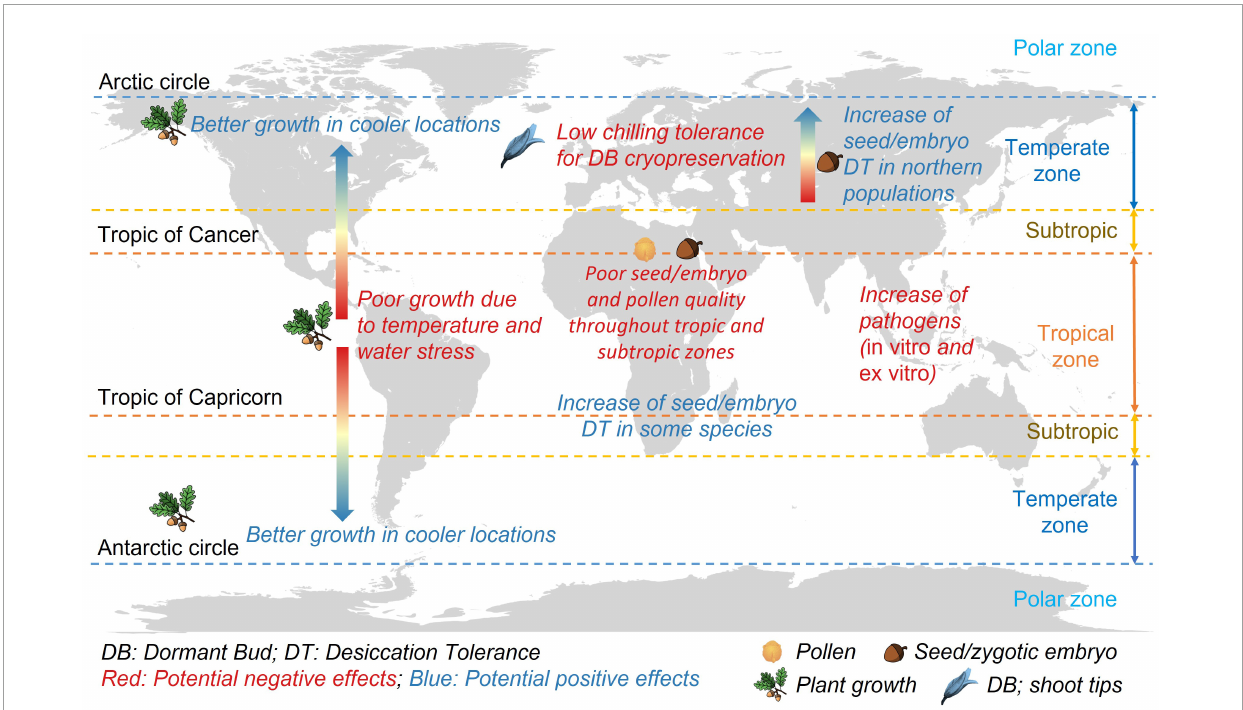
FIGURE2 Summary of the effects of climate change on the ex situ conservation options of recalcitrant seeded